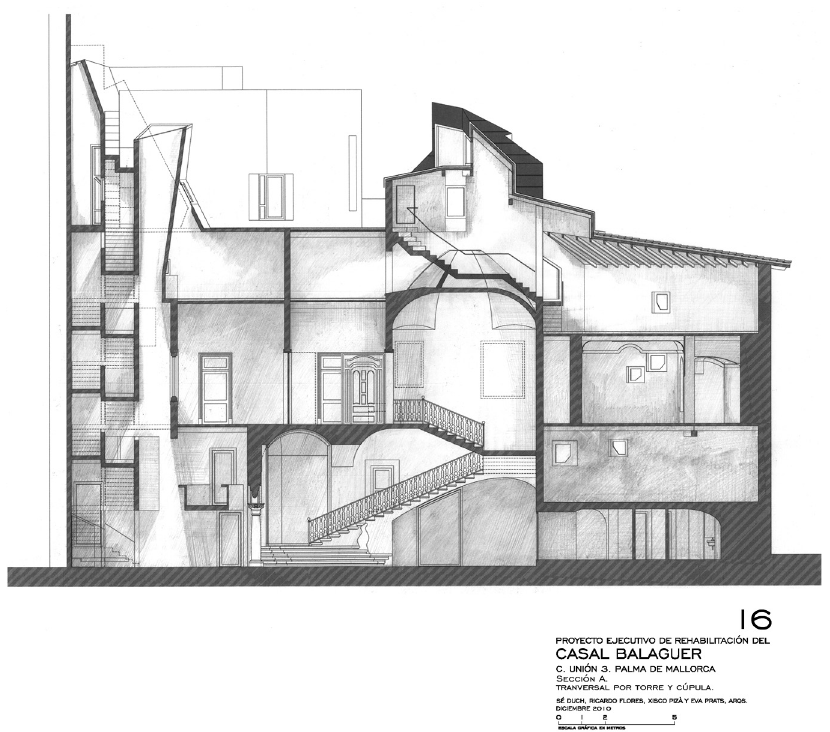
Figure 5. Flores Prats. Casal Balaguer (2009– ). Cross section through new circulation and light